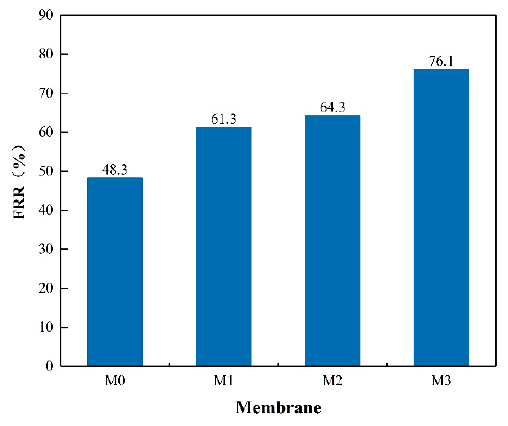
Figure 10. Water flux recovery ratio of the MXene/PSF membranes.